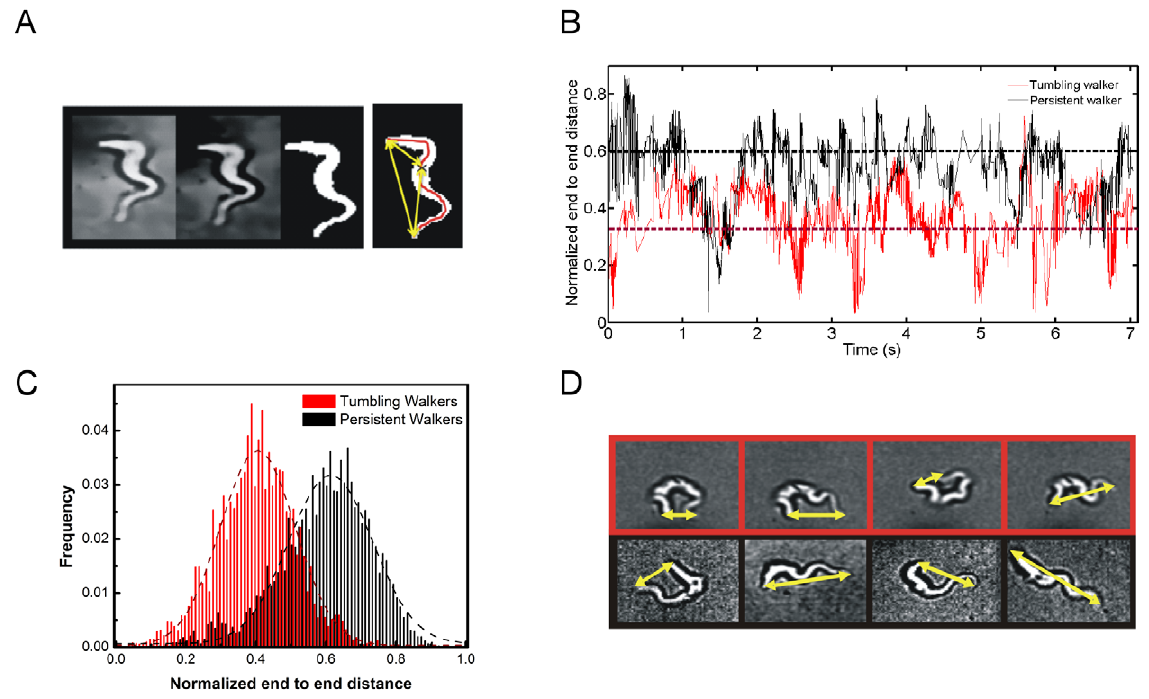
Figure 4. End-to-end distance. (a) Image processing to obtain a skeleton line, and thereby extract the end-to-end distance. (b) Typical time series of end-to-end distance (normalized to cell length) (c) Population distributions of end-to-end distance in persistent and tumbling walkers (d) Snapshots from movies showing that persistent cells are indeed more stretched (black boxes) than tumbling walkers (red boxes).